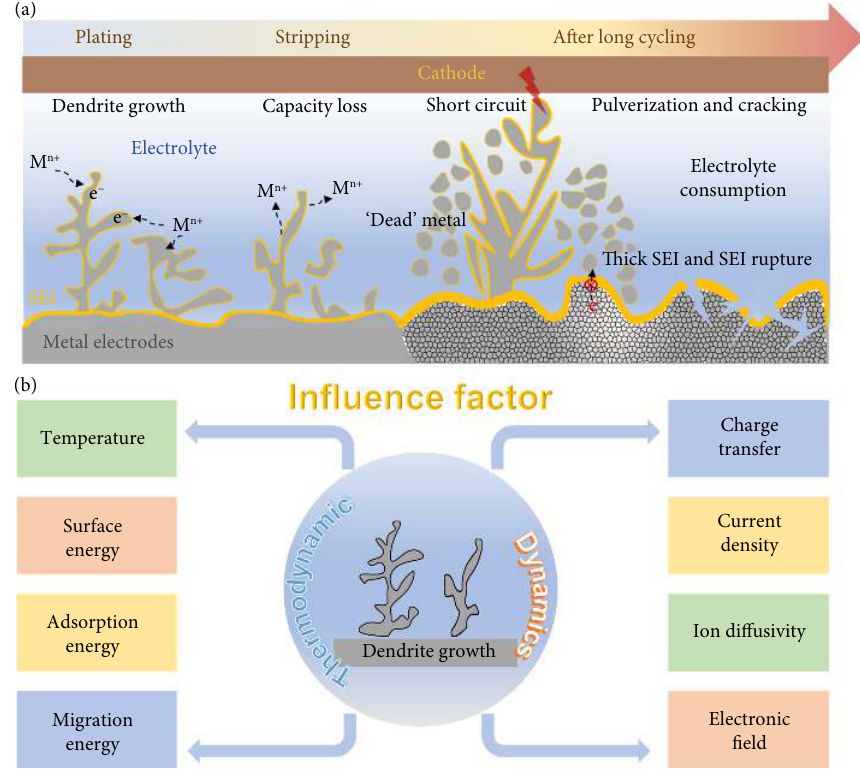
Fig. 2 (a) Schematic diagram of interface issues of solid metal anode. (b) Factors affecting dendrite Figure 2(a), the metal dendrites formed in electroplating process can easily detach from the substrate during the stripping process and form dead metals, which lead to the battery capacity fading. Moreover, the unrestricted growth of the metal dendrites can easily